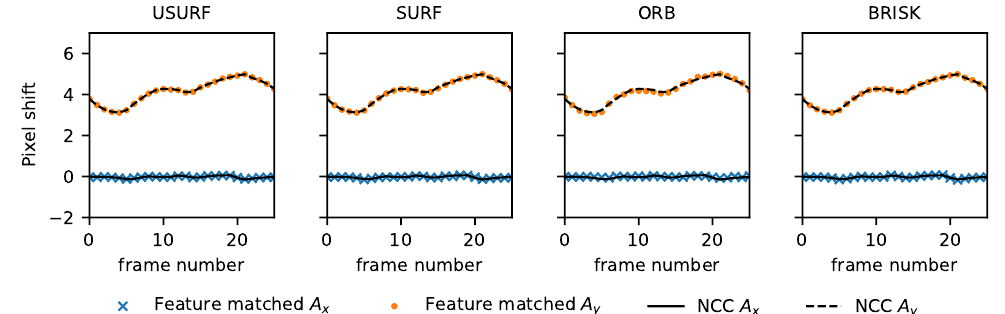
Figure 2. Comparison between experimental speckle velocimetry data processed using the normalised cross-correlation (NCC) and feature tracking methods. The speckle shift found using the NCC method is shown by the solid and dashed lines for the x and y components, respectively. The feature tracking results are shown as the data points, crosses, and dots for the x and y components, respectively.